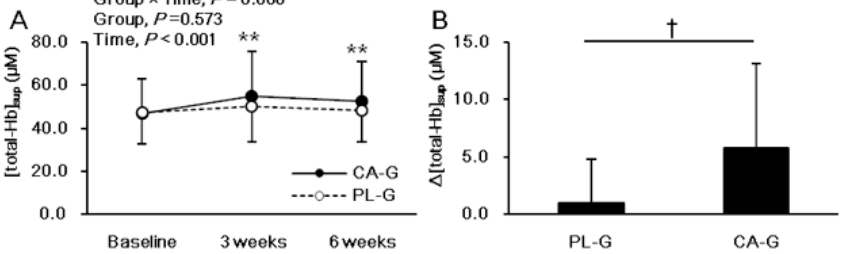
Figure 2. Mean (± SD) [total-Hb] sup , which is an indicator of brown adipose tissue vascular density in the supraclavicular region, at baseline and at 3 and 6 weeks after ingestion of capsinoid ( ● ) and placebo ( ○ ) in all participants ( n = 38) ( A ). Mean (± SD) changes in [total-Hb] sup after the 6-week intervention in all participants ( n = 38) ( B ). There were significant intervention interactions (group ×